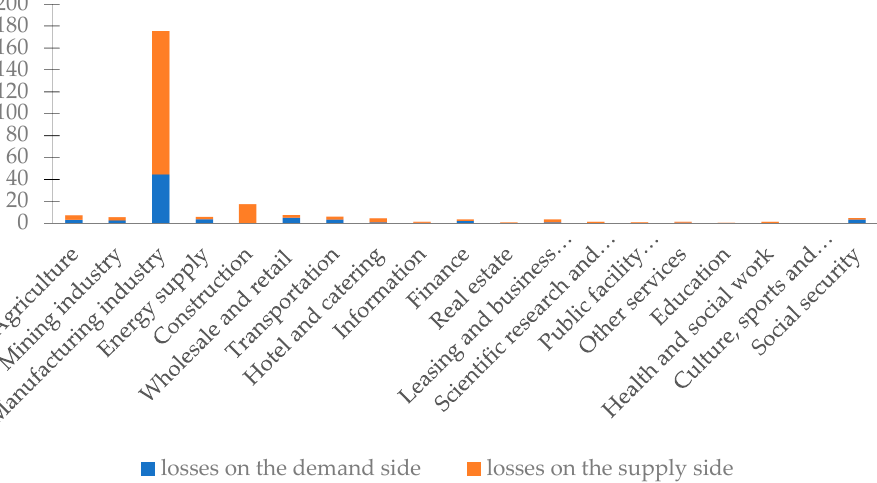
Figure 3. Indirect economic losses on the demand/supply side of various sectors in China (unit: CNY 100 million).